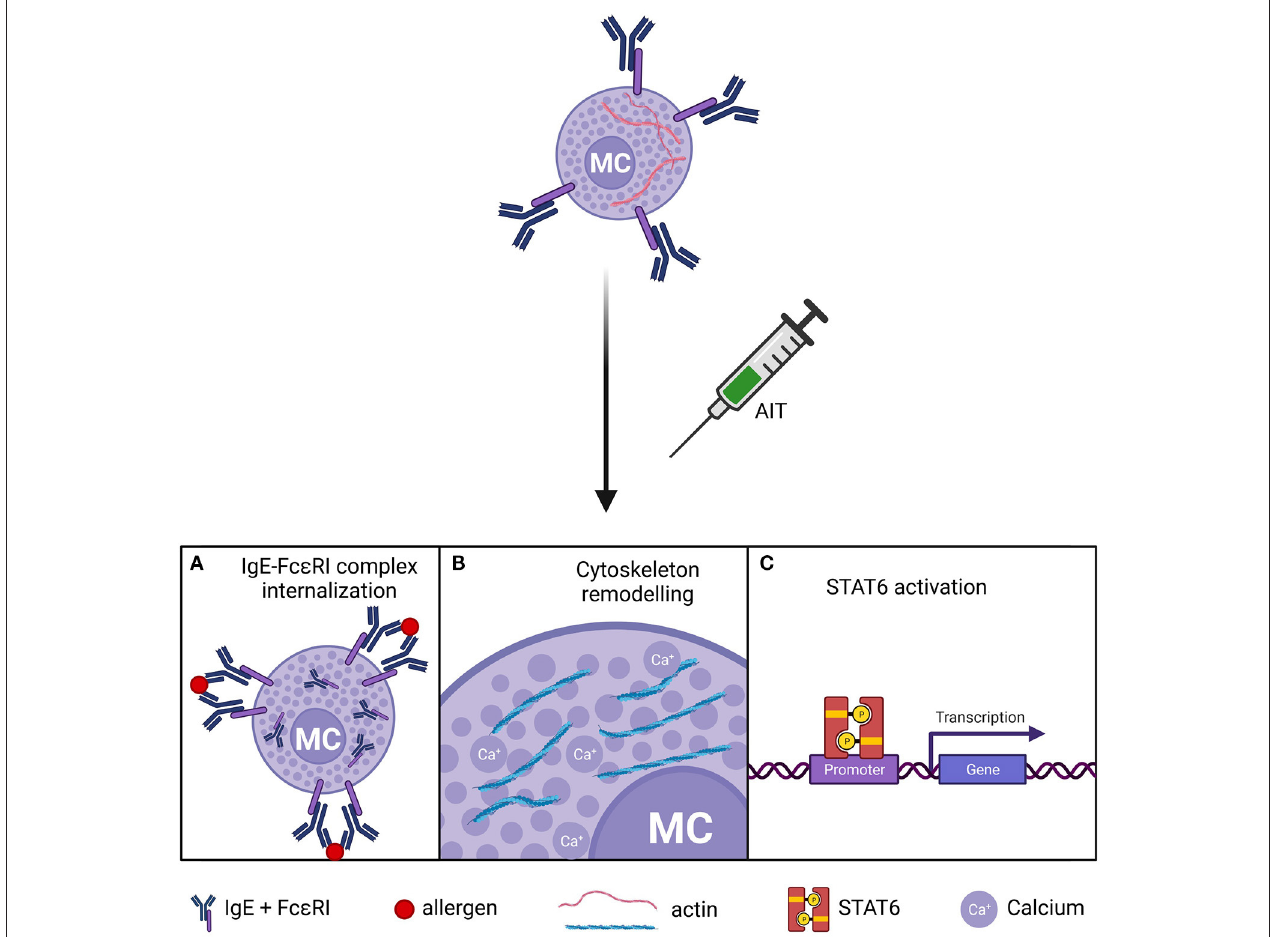
FIGURE 2 | Putative mechanisms of MC desensitization in AIT. (A) Internalization of the IgE-Fc ε RI complex. (B) Actin-cytoskeleton remodeling and impaired calcium flux in MC after. (C) Dysregulation of STAT6 pathway. MCs, mast cells.